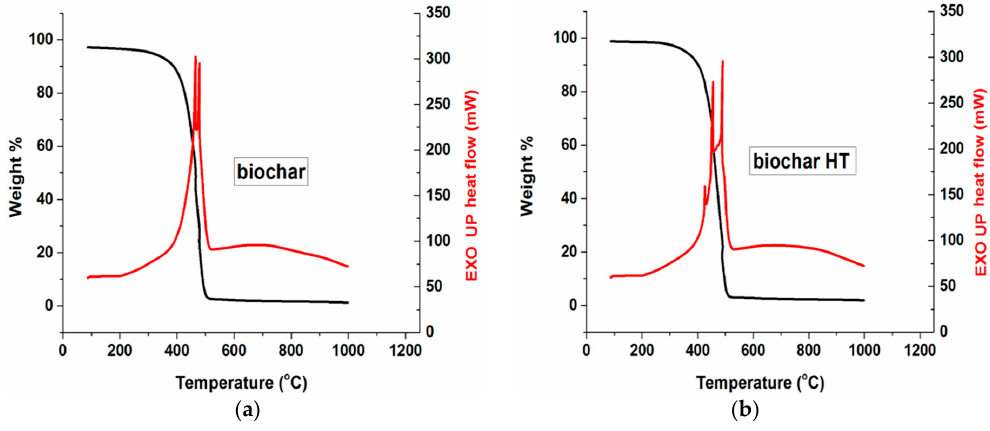
Figure 2. TGA-DSC curves of ( a ) biochar and ( b ) biochar HT.